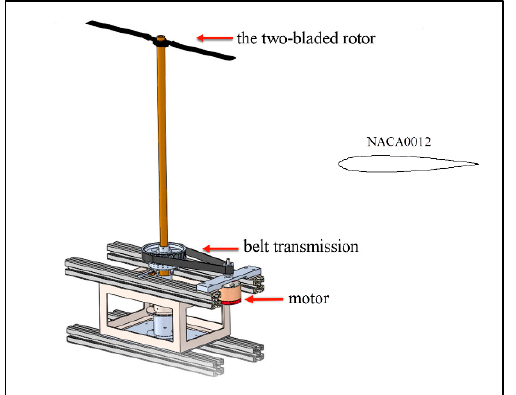
Table 1. Properties of the test rotor in this experiment.